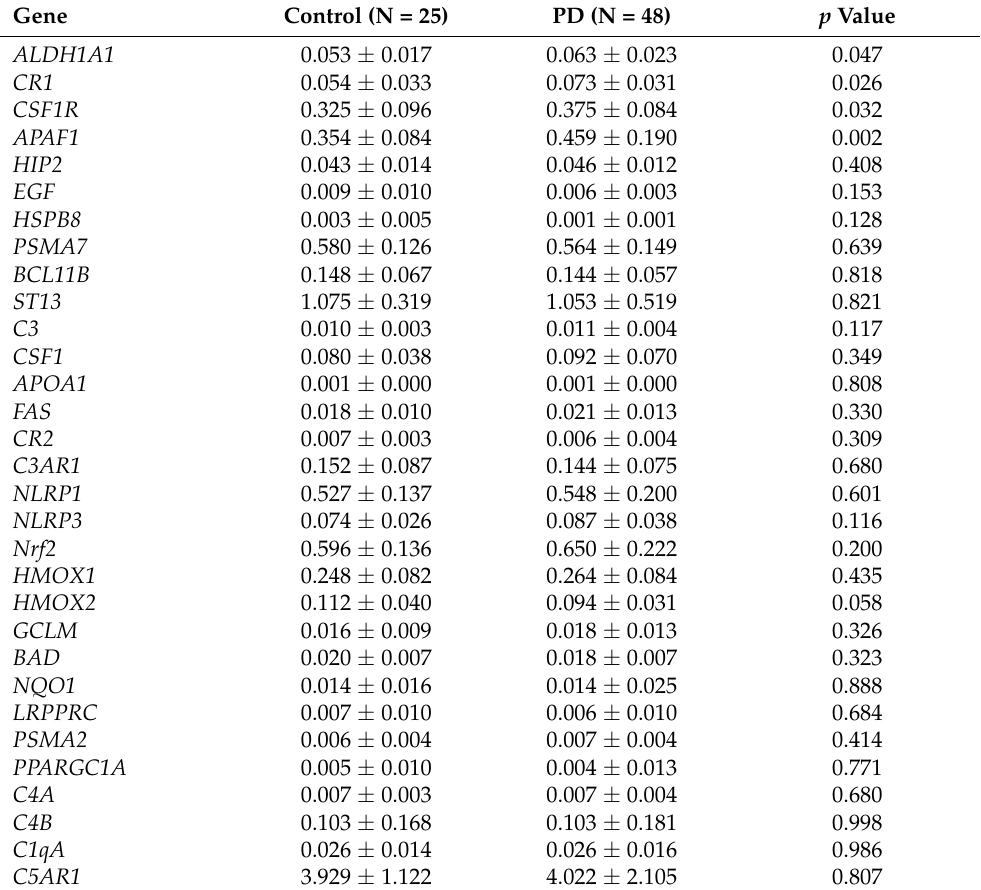
Table 2. Expression levels of 52 genes in the discovery cohort of Parkinson’s disease patients (PD) and